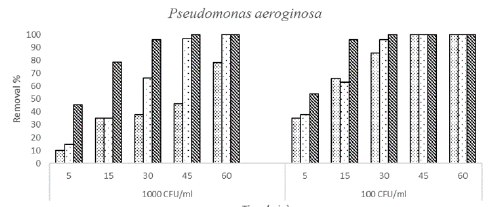
Fig. 3 Comparison energy consumption of the electrochemical reactor with current density 20-100 mA